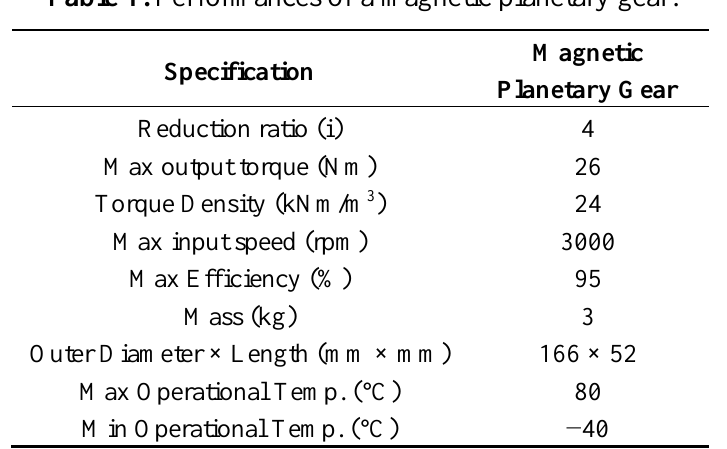
Table 1. Performances of a magnetic planetary gear.